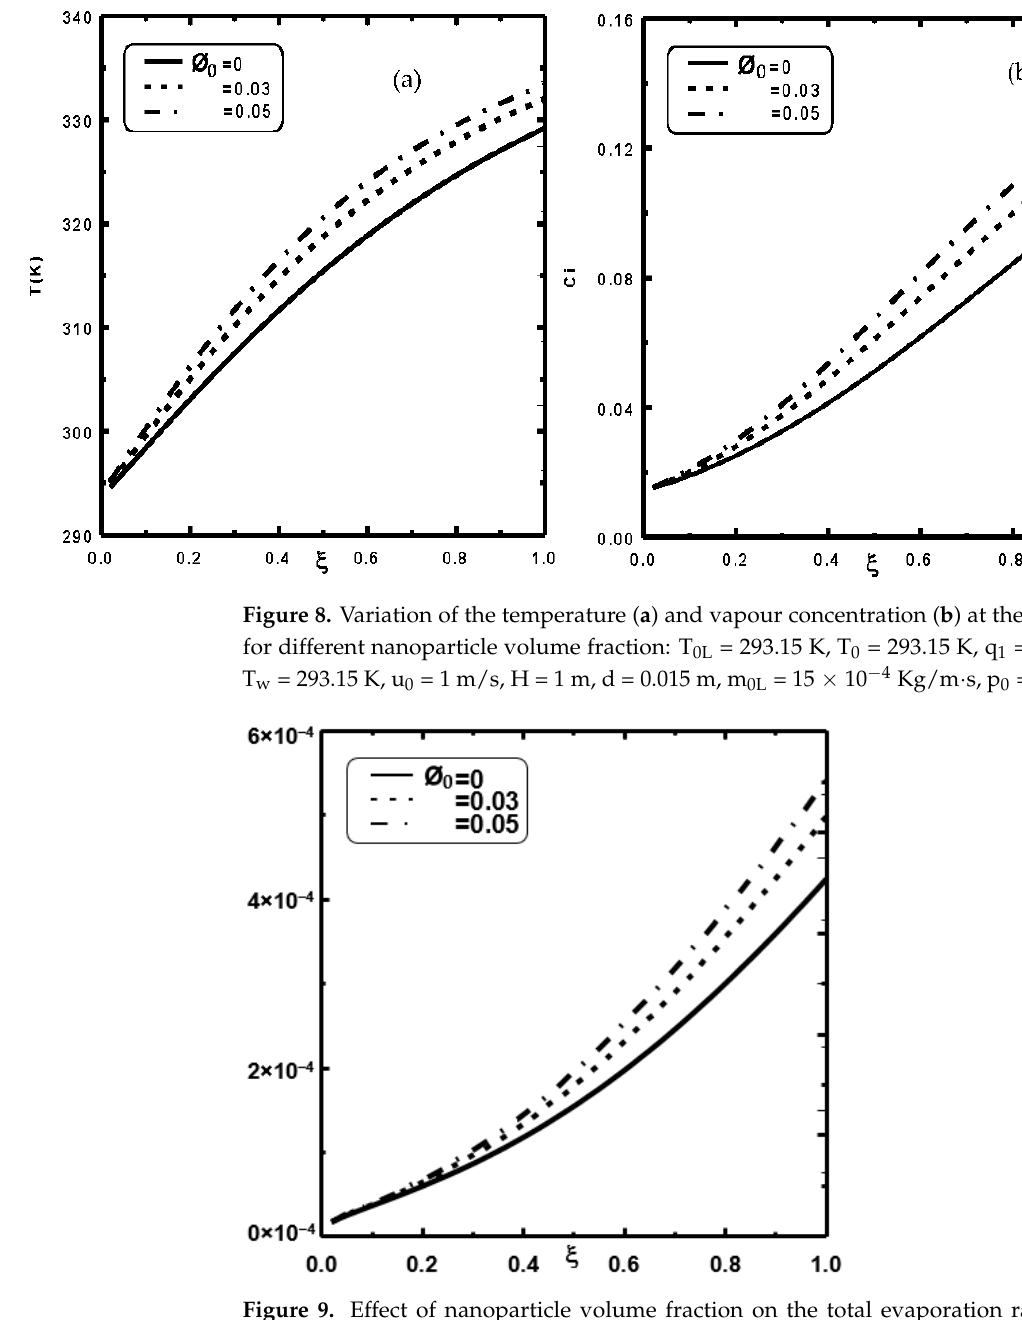
Figure 7. Effect of nanoparticle volume fraction on the temperature ( a ) and the vapor concentration ( b ) at the channel exit: T 0L = 293.15 K, T 0 = 293.15 K, q 1 = 3000 W/m 2 , c 0 = 0, T w = 293.15 K, u 0 = 1 m/s, H